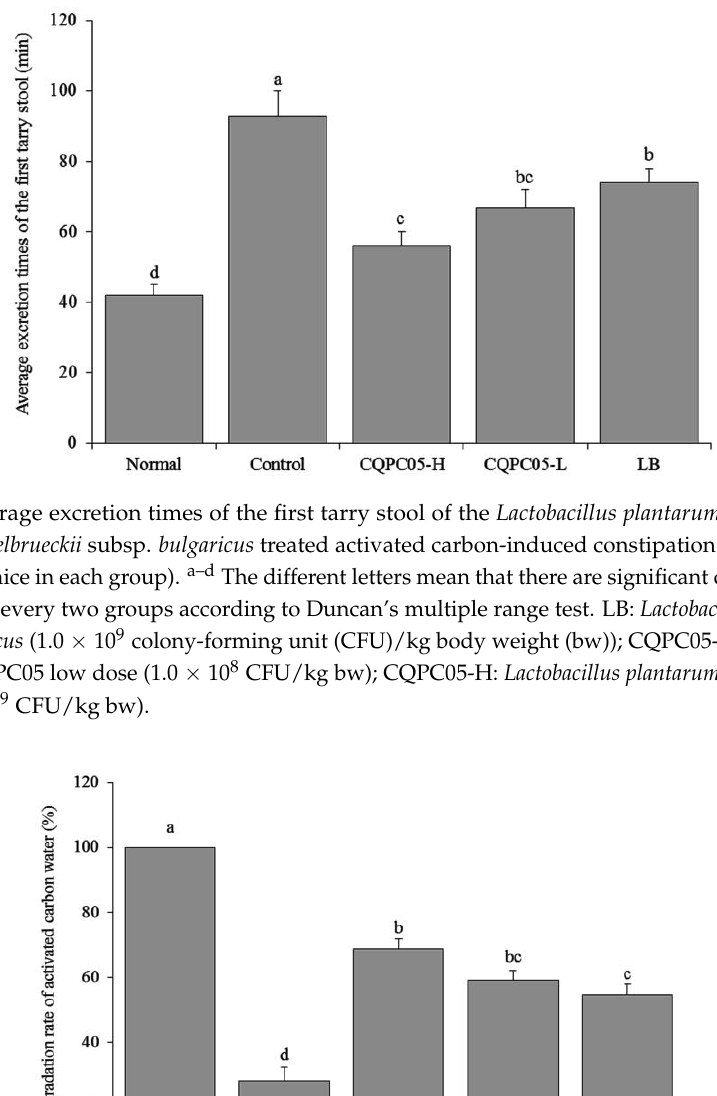
Table 2. Serum MTL, Gas, ET, SS, and AChE levels of Lactobacillus plantarum CQPC05 and Lactobacillus delbruechii subsp. bulgaricus treated activated carbon-induced constipation mice. Treatment Normal Control